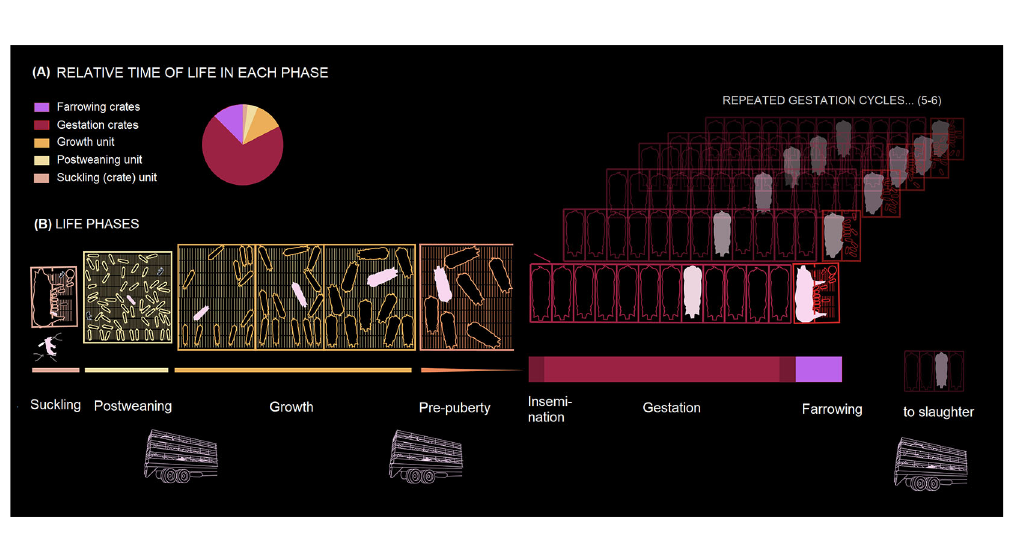
Figure 1. Life phases of a typical female breeding pig (pink) in conventional housing systems. (A) Relative time of life in each phase (pie chart), (B) Life phases are ordered horizontally, from left to right, representing the passage of time. Except for the gestation and farrowing cycles (which are experienced five to six times by an average sow), enclosure widths roughly coincide with the duration of the corresponding phase. The thickness of lines underneath production phases is proportional to the time of life spent at each